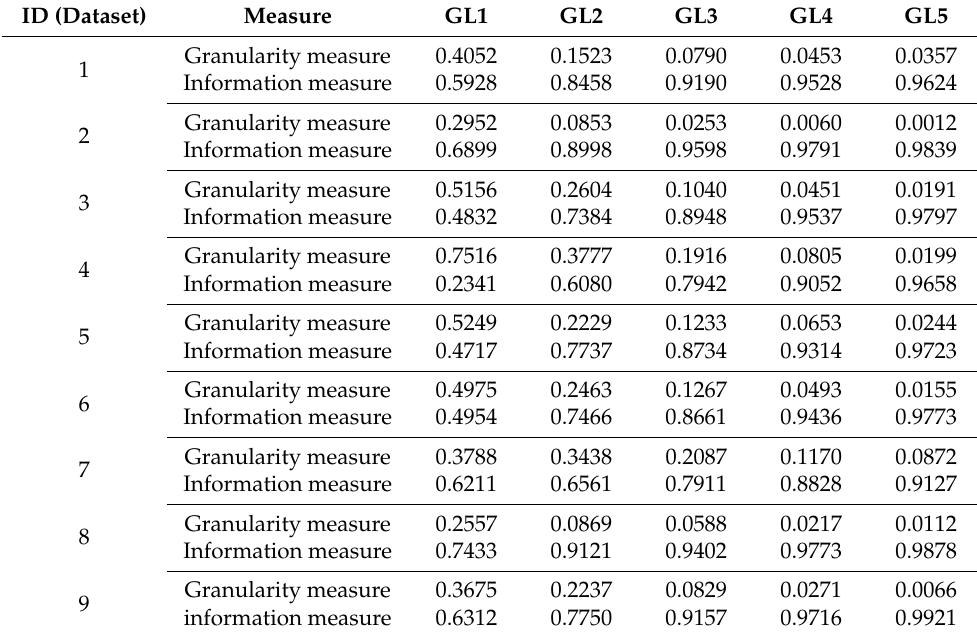
Figure 3. The change of MD between different granular spaces. Each dataset is represented by ID number. Table 2. Granularity measure and Information